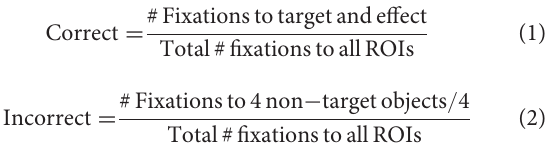
Frontiers in Psychology |